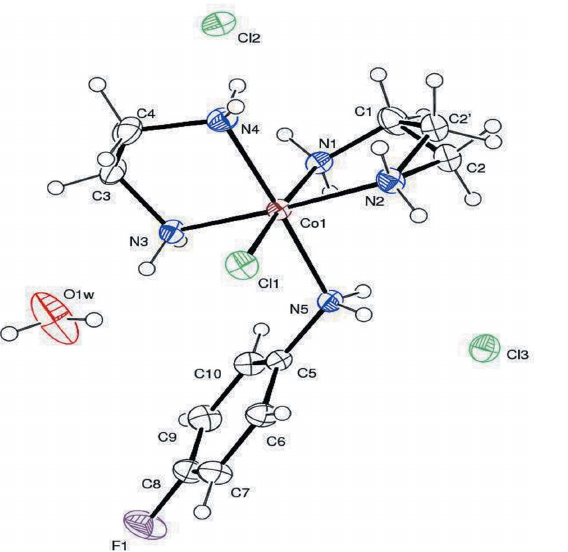
Figure 1 The structural entities of the title complex, showing the atom-labelling scheme. Displacement ellipsoids are drawn at the 30% probability